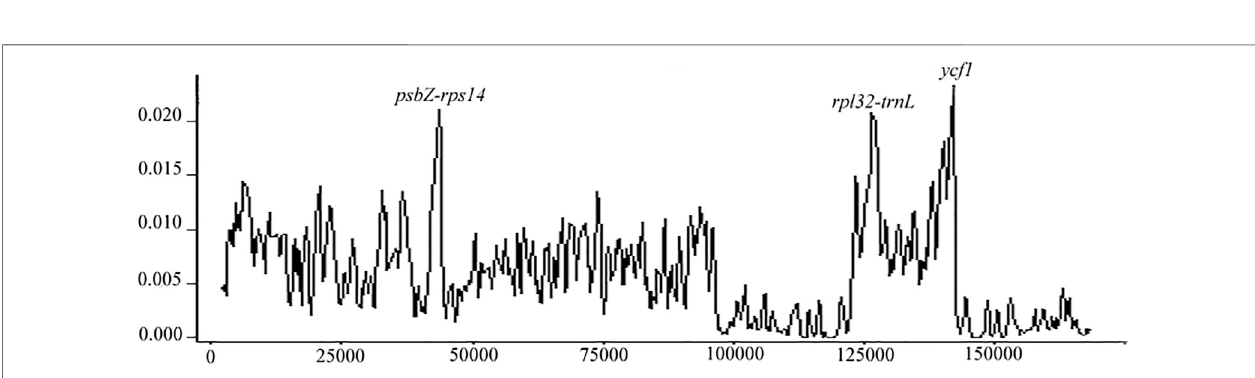
FIGURE 2 | Sliding-window analysis on the cp genomes for Acer